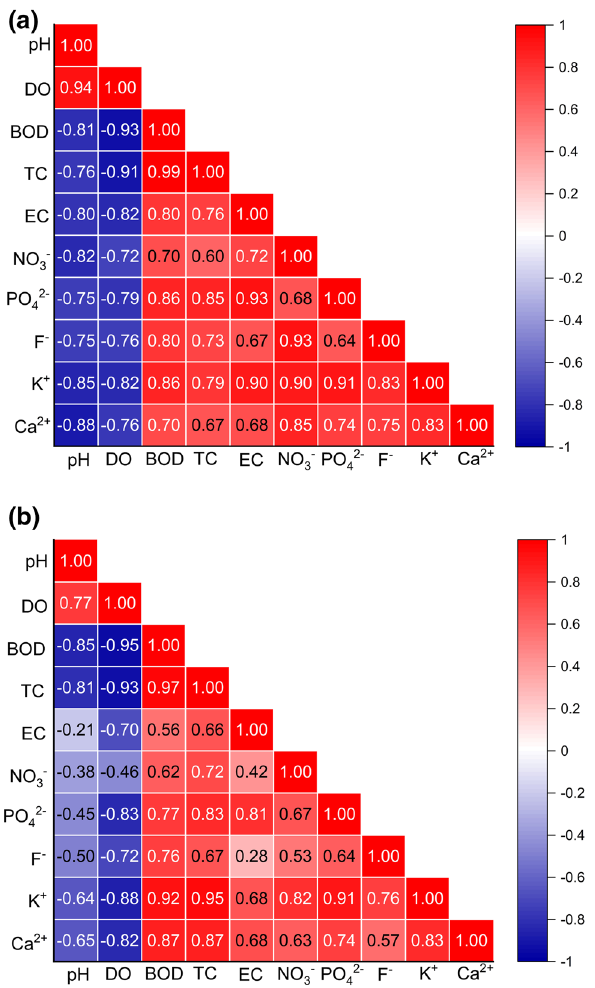
Fig. 4 Pearson’s correlation matrix for a January 2015 and b October 2019 representing the dependence of water quality parameters